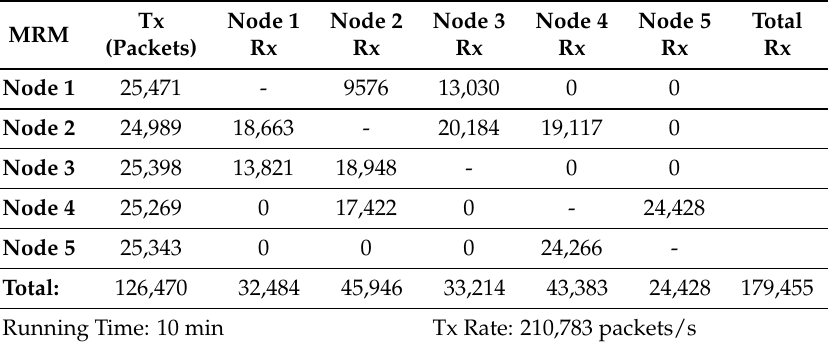
Table 6. Packet delivery: Cooja MRM